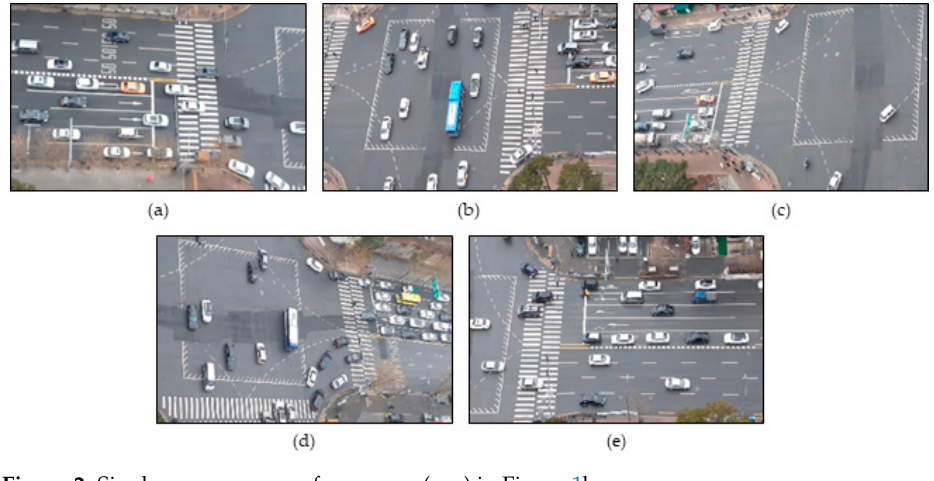
Figure 2. Single-camera scenes from areas ( a – e ) in Figure 1b.